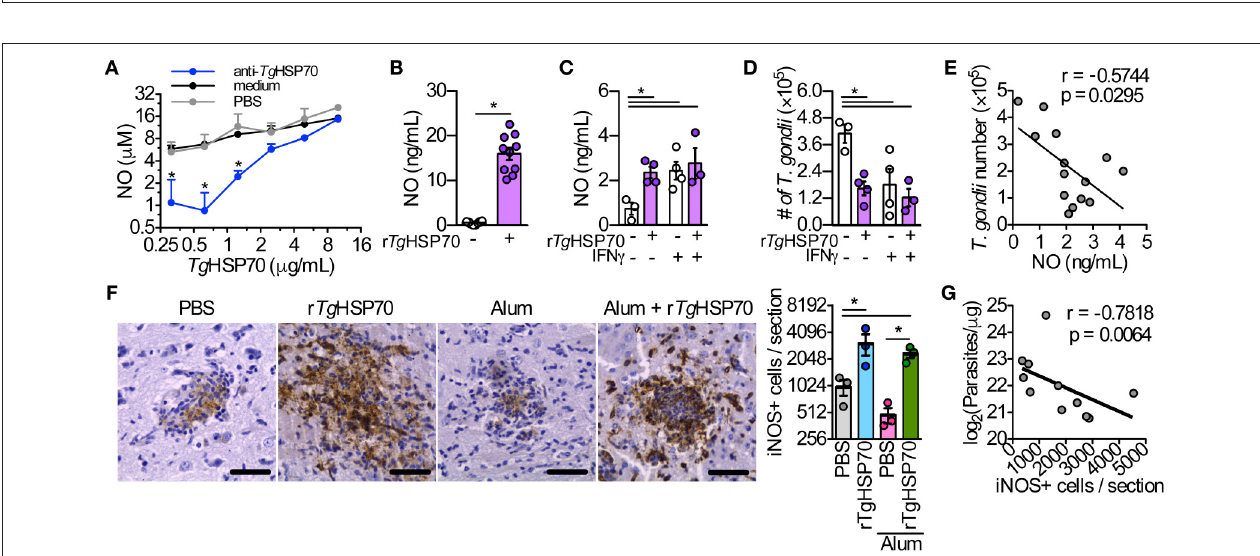
FIGURE 4 | Anti- r Tg HSP70 antibodies do not mediate inhibition and complement-mediated lysis by direct binding to parasite. (A) 2F1 RH tachyzoites were suspended in medium containing 5% heat-inactivated, or not inactivated, serum from uninfected control (PBS group), uninfected r Tg HSP70-immunized or 30 days-infected mice. These parasites were used to infect NIH fibroblasts and parasite numbers was accessed after 24h. (B) 2F1 RH tachyzoites were used for testing complement-mediated lysis using sera from all groups of immunization prior and after infection. Percentage of parasite lysis is shown. Wells above the graphic illustrate the chromogenic reaction quantified by this assay where red color indicates parasite lysis. (C) Immunofluorescence using sera from 30 days-infected (PBS group) or r Tg HSP70-immunized mice in non-permeabilized T. gondii RH tachyzoites. Scale bar represents 10 µ m. (D) 2F1 RH tachyzoites were incubated with heat-inactivated sera from uninfected control (PBS group) or uninfected r Tg HSP70-immunized mice and used to infect C57BL/6 peritoneal macrophages. Parasite numbers were evaluated after 24 h of infection. Data are representative of two independent experiments. * P < 0.05, unpaired two-tailed t -test. Error bars indicate mean ±